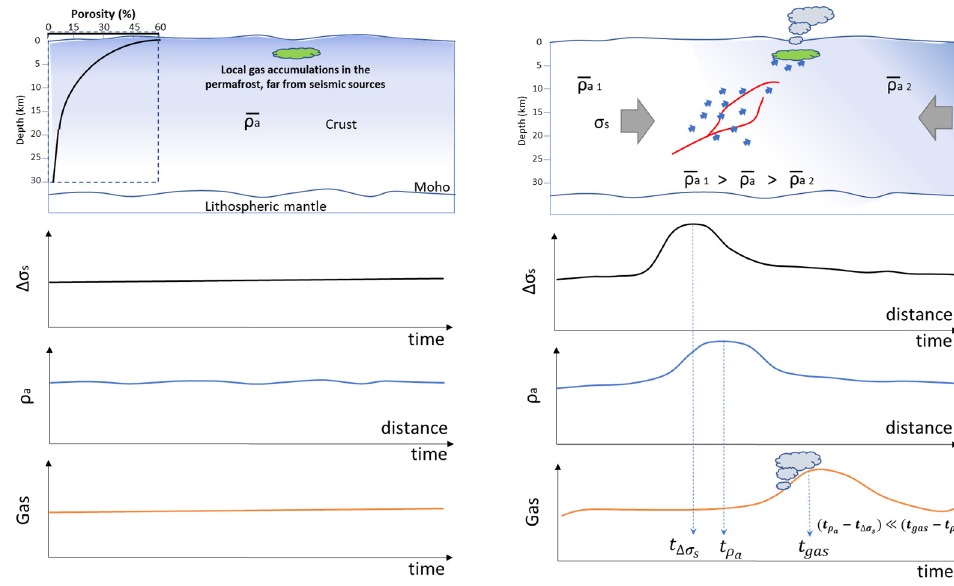
Figure 6. Schematic representation of the generation processes previous to (left) and after the seismic swarm. With no significant temporal variations in the tectonic stress ( ∆ σ s ), no changes are expected in ρ a nor in fluid migration that triggers pore pressure and gas emissions. In contrast, the relevant variations of the ∆ σ s in short times promote variations of porosity, ρ a , pore pressure (suggested by the faded shift of the blue background to the right of the top right panel), fluid migration (blue arrows), and gas emissions from local gas accumulations in the permafrost (represented by a green cloud). Time onsets of these processes could meet the following rule: 𝑡 (cid:3096) ) . (cid:3276)